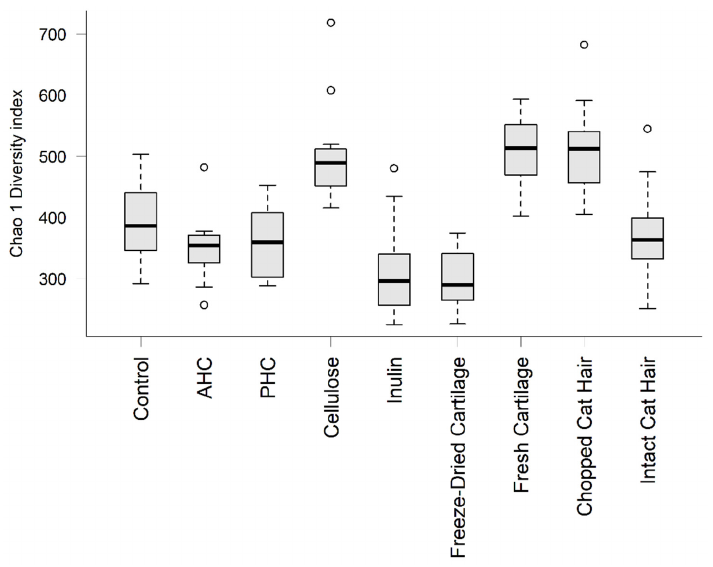
Figure A2. Assessment of alpha diversity using the Chao1 diversity index from samples following in vitro fermentation of substrates at the 24-h time point using high protein faecal inoculum (PD). Small circles denote outliers.